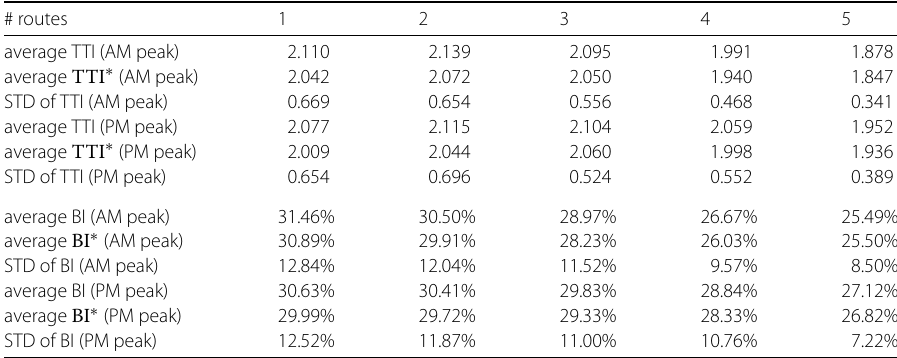
Table 1 Mean values and STD of travel time index and buffer index of users taking different number of trips. The TTI ∗ and BI ∗ indicate the mean values are calculated in the 95% confidence intervals # routes 1 2 3 4 5 average TTI (AM